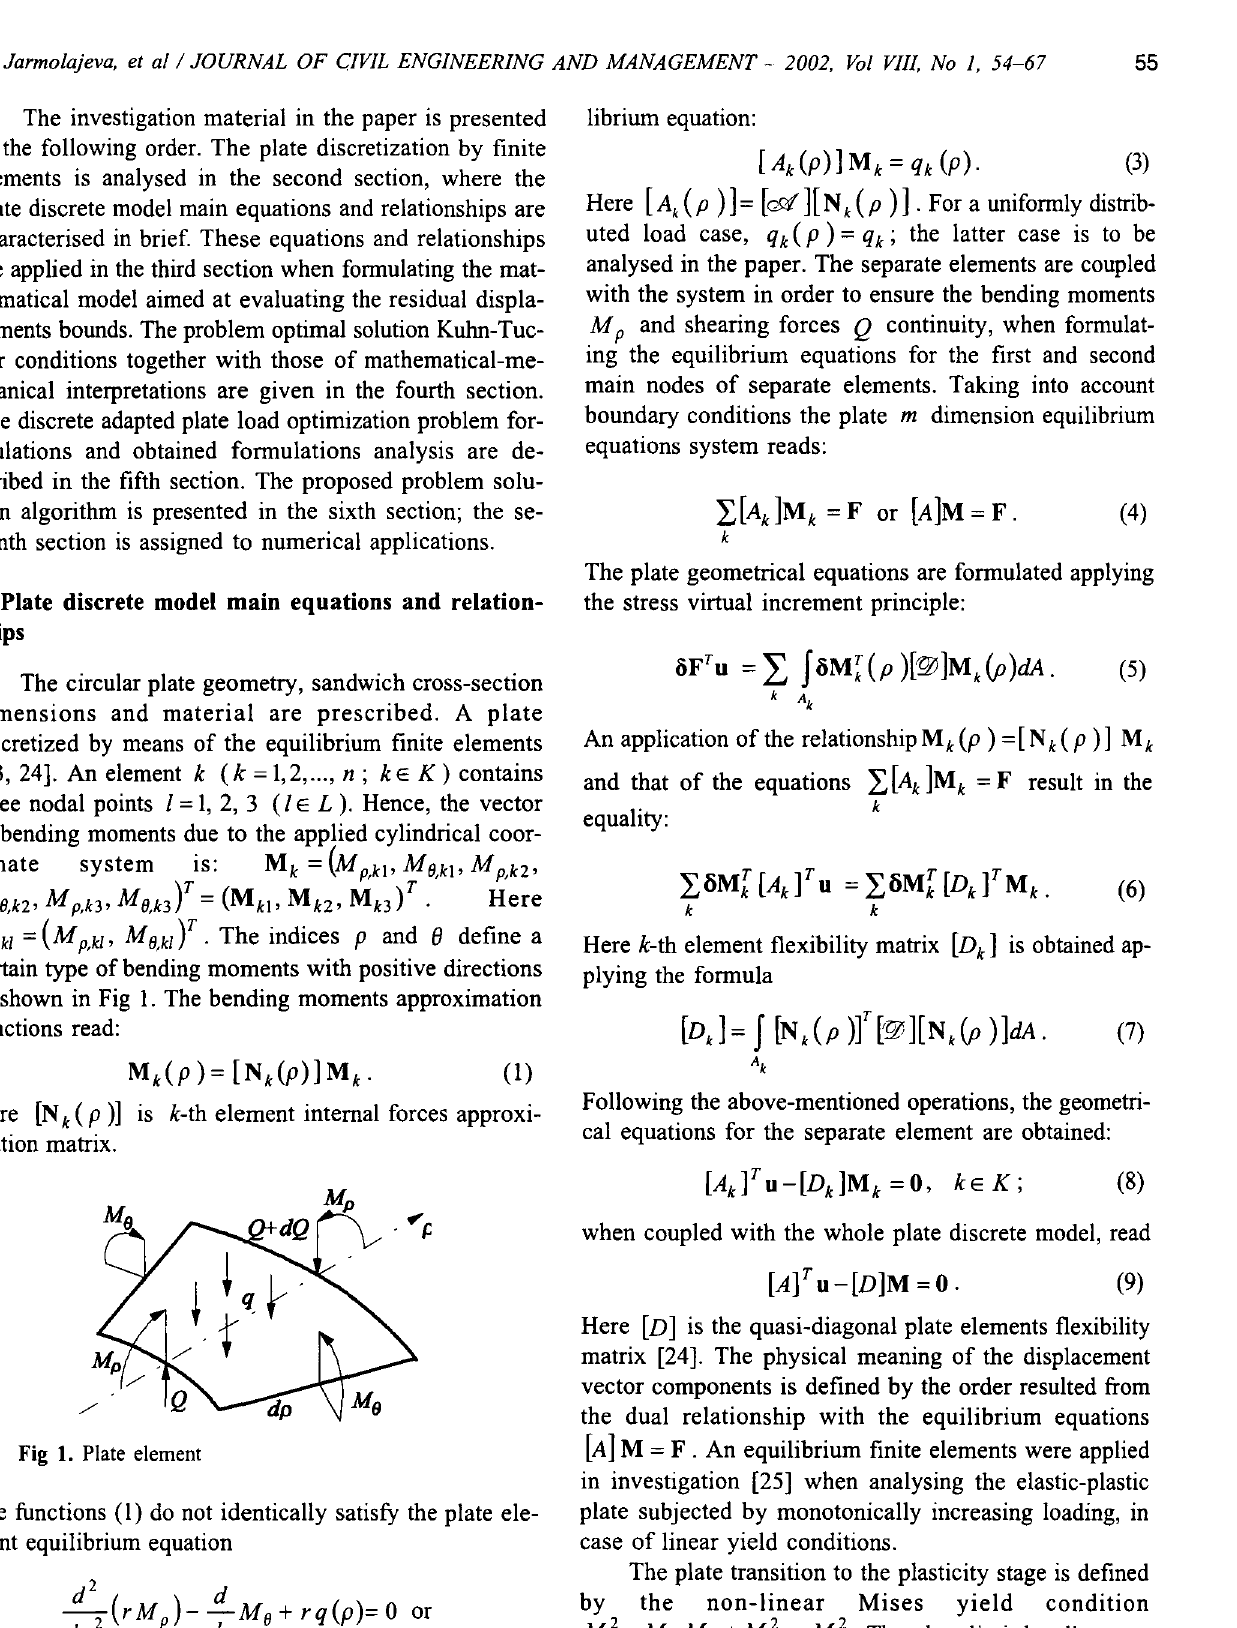
Therefore the discrete model equilibrium is ensured for the plate elements and main nodes. The substitution of the relationship (I) by the formula (2) after